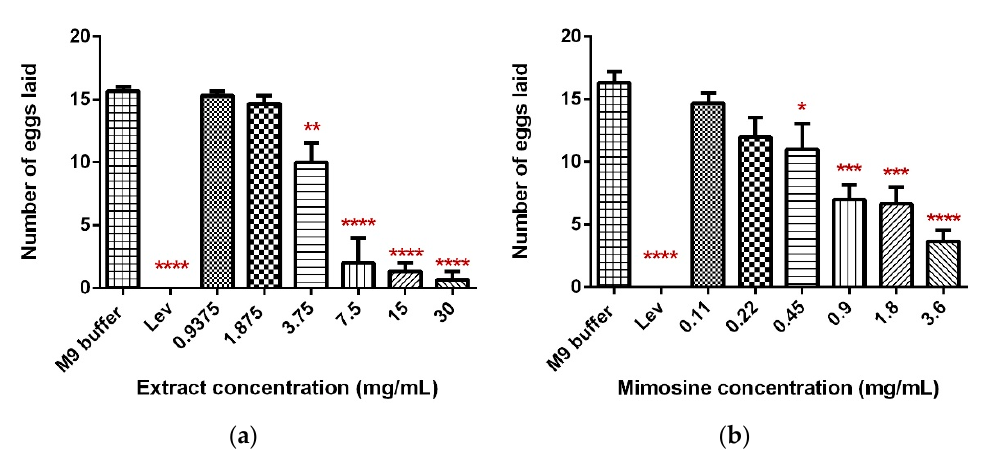
geal pumping activity using the NemaMetrix Screenchip TM System. Exposure to different